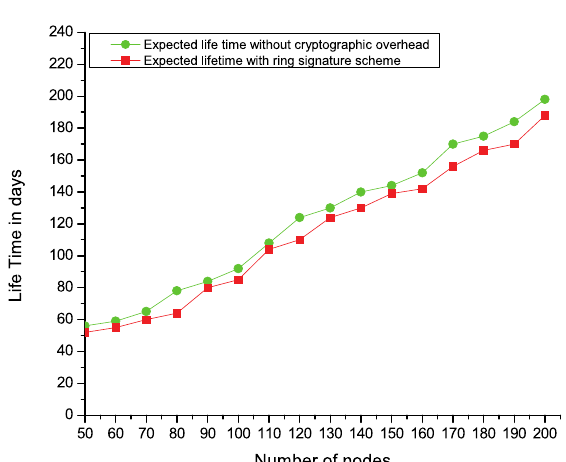
Figure 4. Expected lifetime Vs node density.